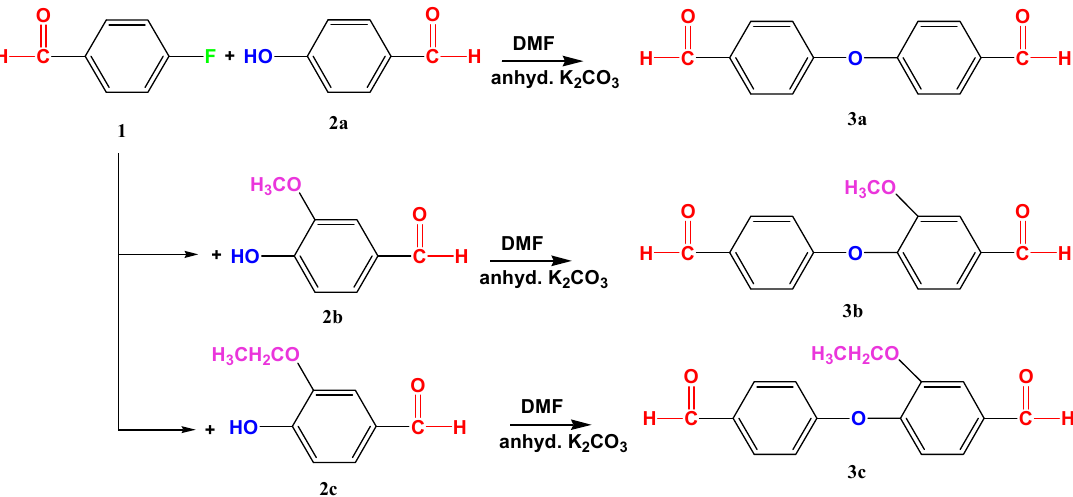
Figure 1. Synthesis of aromatic bis-aldehyde monomers by reacting 4-fluorobenzaldehyde ( 1 ) with 4-hydroxybenzaldehyde ( 2a ), 3-methoxy-4-hydroxygenzaldehyde ( 2b ), and 3-ethoxy-4- hydroxybenzaldehyde ( 2c ). The synthesized monomers are 4-(4 (cid:48) -Formyl-phenoxy)benzaldehyde ( 3a ), 3-Methoxy-4-(4 (cid:48) -formyl-phenoxy) benzaldehyde ( 3b ), and 3-Ethoxy-4-(4 (cid:48) -formyl-phenoxy) benzaldehyde ( 3c